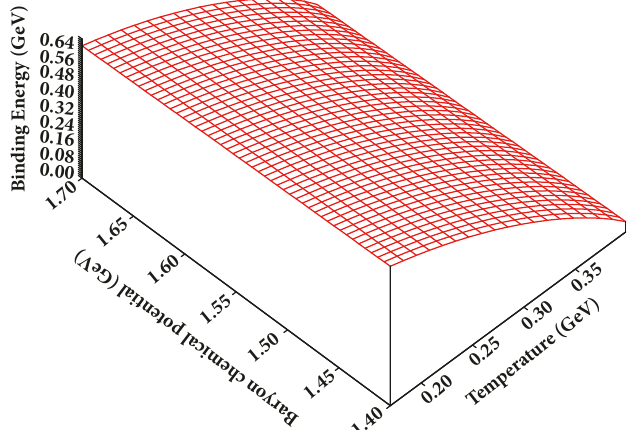
Figure 7: The binding energy of 1S charmonium is plotted as a function of temperature and baryonic chemical potential in 3D space in the anisotropic medium ( 𝜉 =